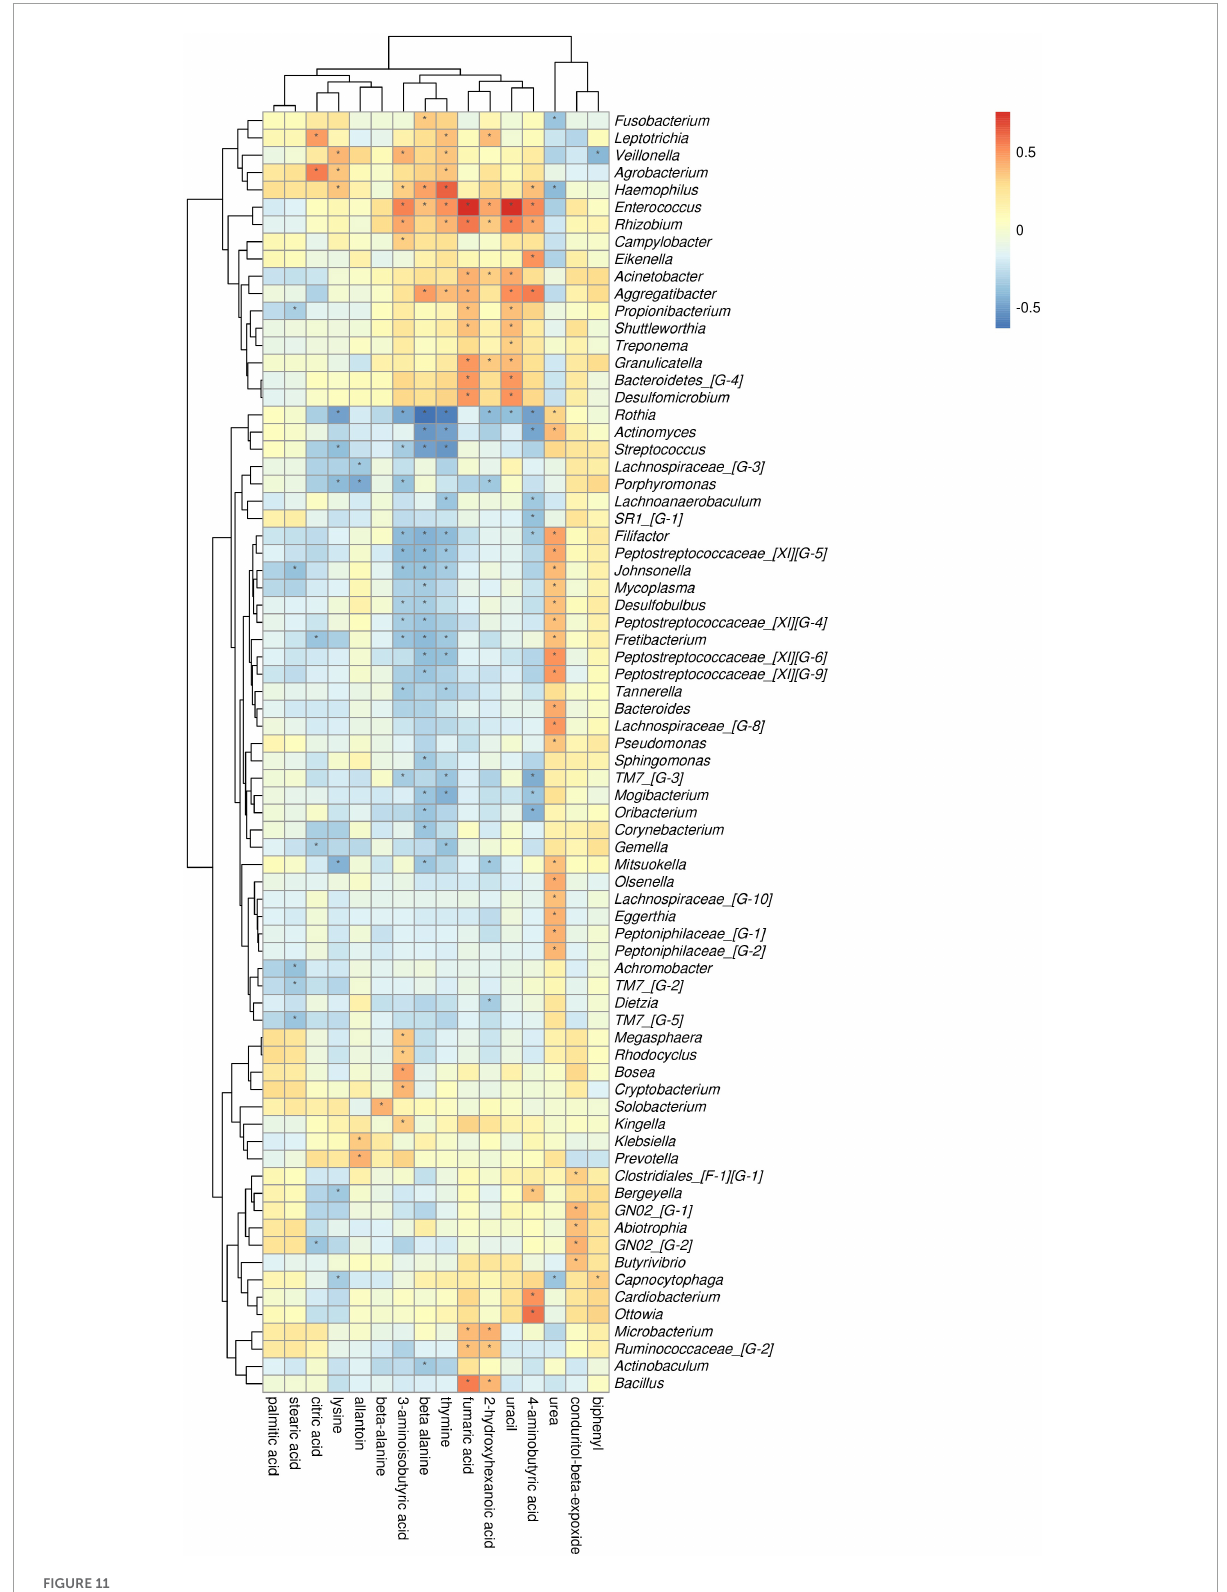
FIGURE11 Association of microbial genera with differential metabolites in AgP and